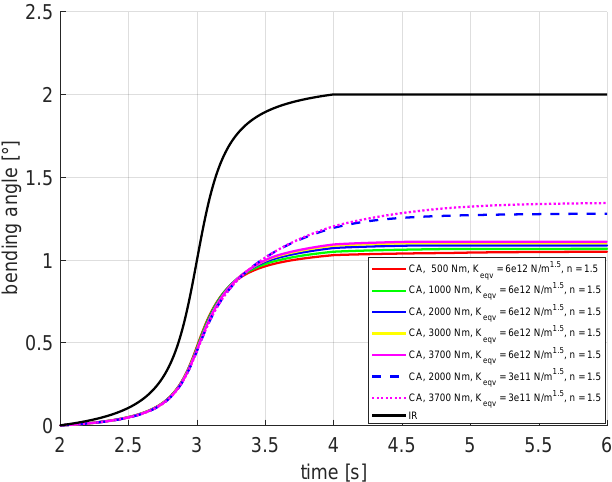
Figure 7. Cage deflection angle at different load torques for several equivalent contact stiffnesses K eqv